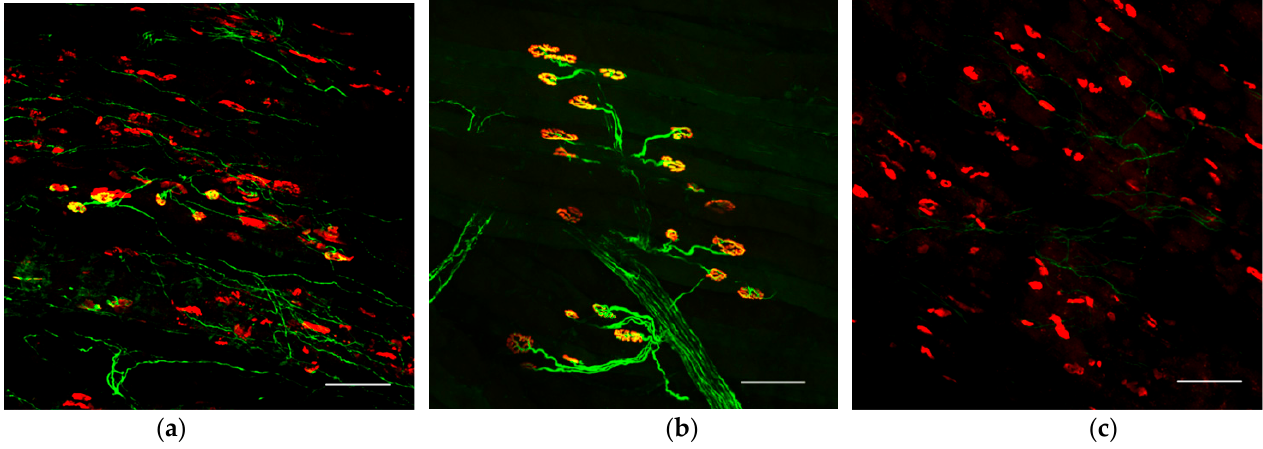
Figure 4. Immunohistological evaluation of the neuromuscular junction of extensor hallucis longus (EHL) in ( a ) transplanted limbs (reinnervated axons enter acetylcholine receptors and form neuromuscular junctions), ( b ) normal limbs, and ( c ) the surgical control limb (without transplantation). Green: Tuj1 ( β III tubulin), Red: α BTX ( α -bungarotoxin). Scale bar = 100 μ m.